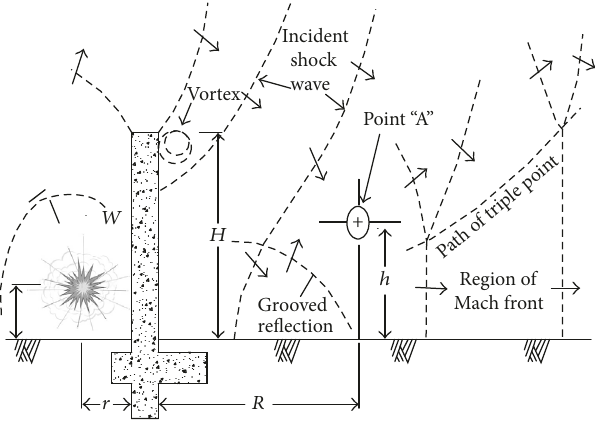
Figure 9: Experimental arrangement and visualization pressure waves trajectories diffracting over the blast wall.